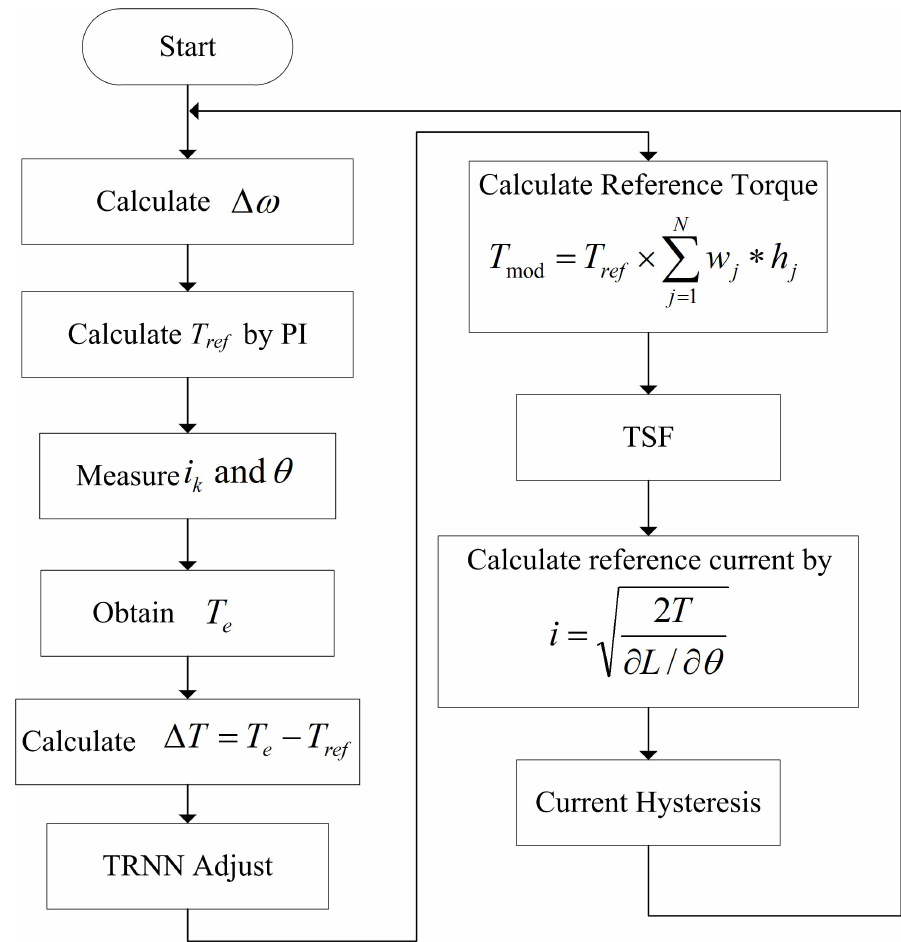
Figure 9. Algorithm flow